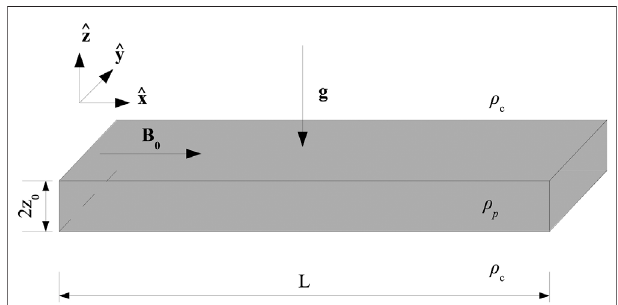
FIGURE5| SketchoftheslabmodelusedbyTerradaset al.(2012).The grey zone denotes the prominece slab of width 2 z 0 , length L , and density ρ p embedded in a coronal plasma of density ρ c , with ρ p > ρ c . A uniform magnetic fi eld, B 0 , is assumed in the horizontal direction. Gravity, g , acts towards the negative vertical direction. Credit: Terradas et al. (2012), A&A 541, A102, reproduced with permission ©